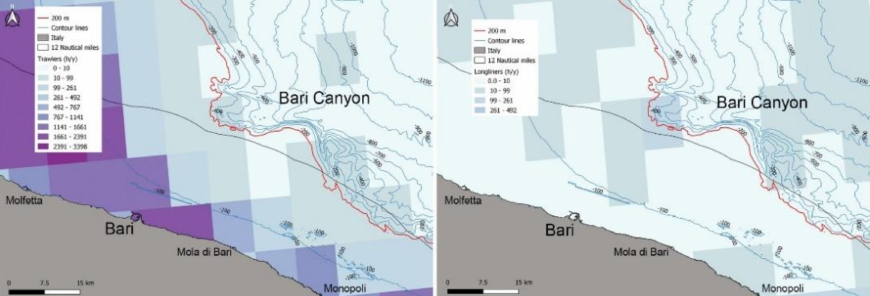
Figure 4. Fishing effort (trawlers on the left side and longliners on the right) on the shelf and slope in the area near the Bari Canyon. Effort (h/year) is indicated on a logarithmic scale. Contour lines are spaced 100 m apart; the red line marks the contour line of 200 m. The black line indicates Italian territorial waters (12 nautical